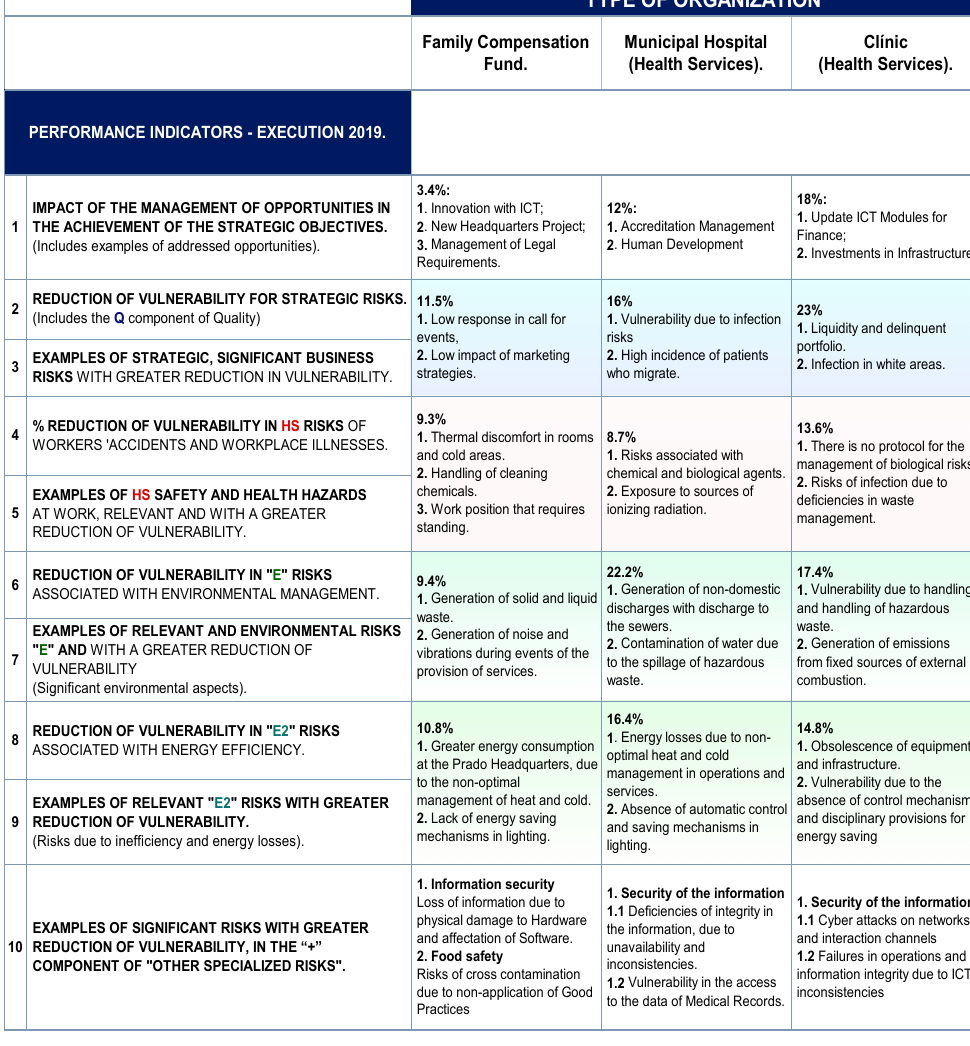
Figure 12. Indicators of vulnerability reduction and incidence of opportunity management in the achievement of strategic objectives: Companies 1, 2, and 3.